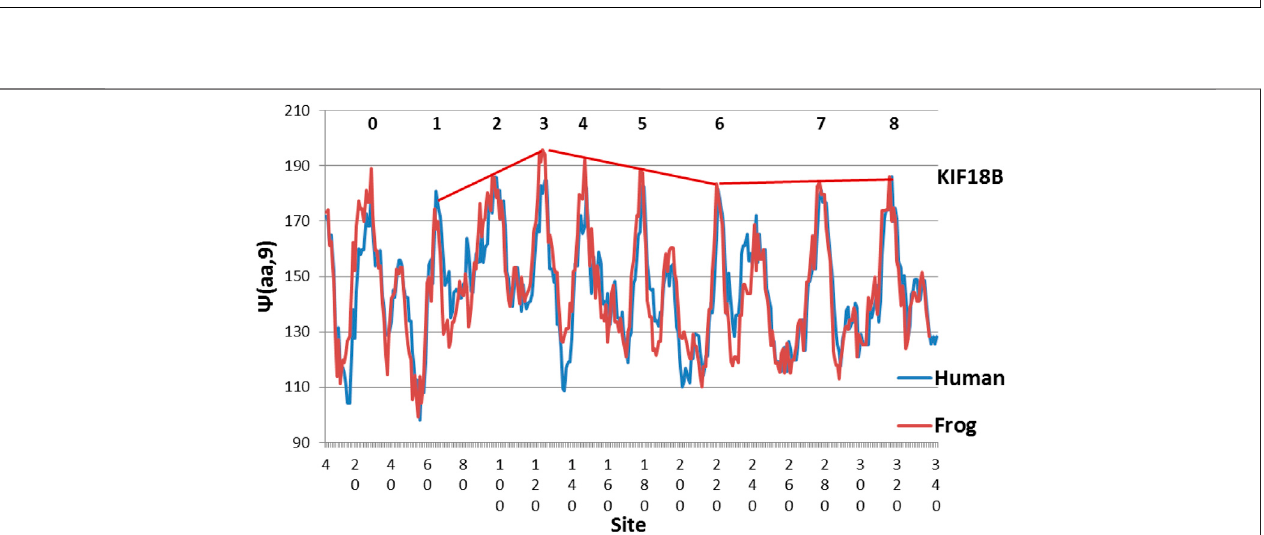
FIGURE 4 | There are still diffences in KIF18B between Human and Rabbit, with the Human peaks more level (MZ scale).